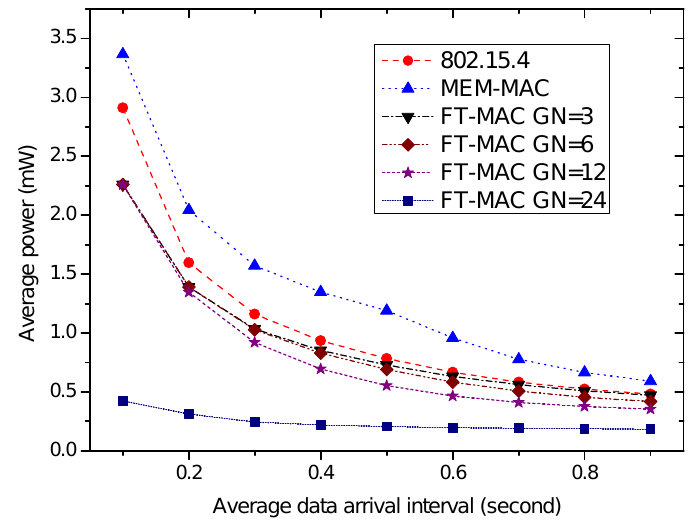
Figure 22. The effectiveness of using multiple DATA subsections and using the CFP